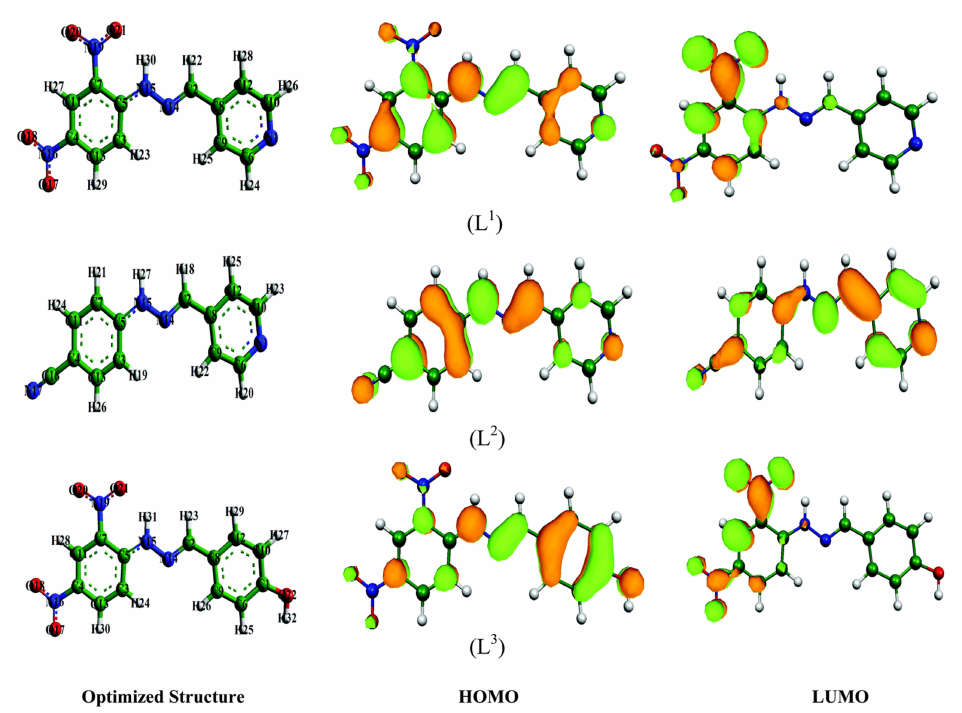
Figure 3. Optimized geometry structures, HOMO and LUMO plots of the three Schiff-base molecules calculated by the B3LYP method, with the SV(P) and SV/J levels of the basis set. (Reprinted with permission from Ref. [111]. Copyright 2016 Royal Society of Chemistry